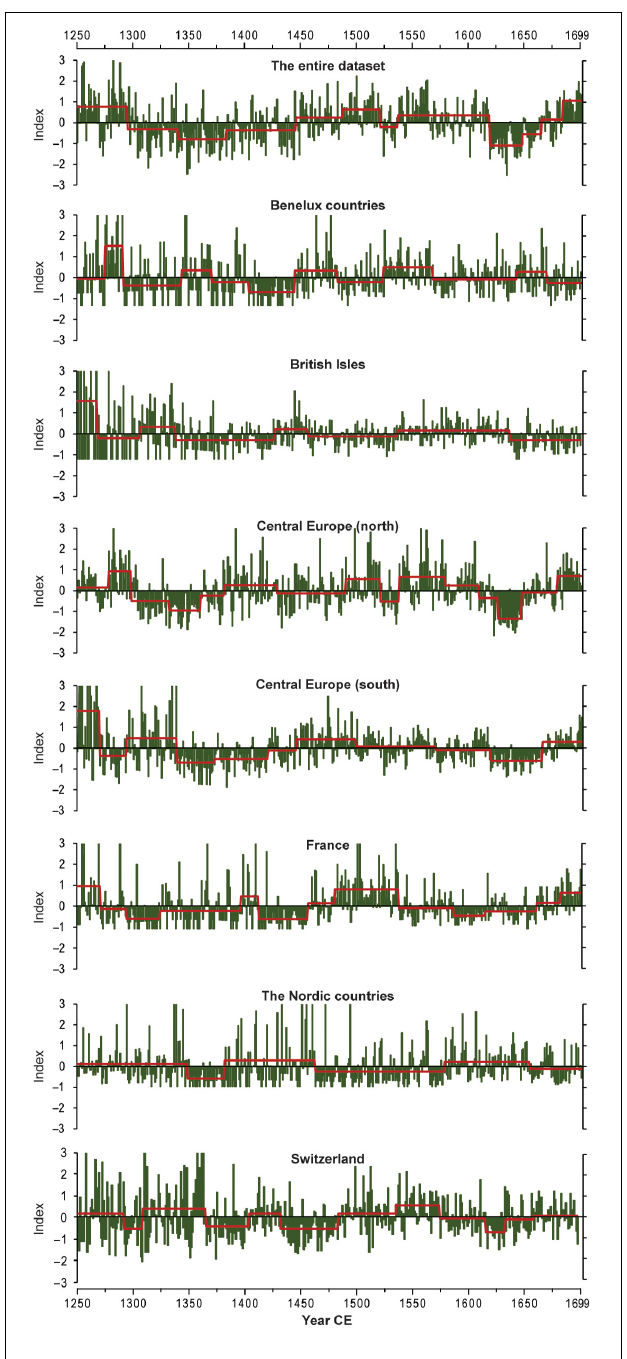
FIGURE 3 | The felling date data 300-year filtered and standardized to z -score values over the entire 1250–1699 CE period for the regional subsets as well as for the full dataset. The red lines show the significant regime shifts in the number of felling dates, using a 30-year cut-off